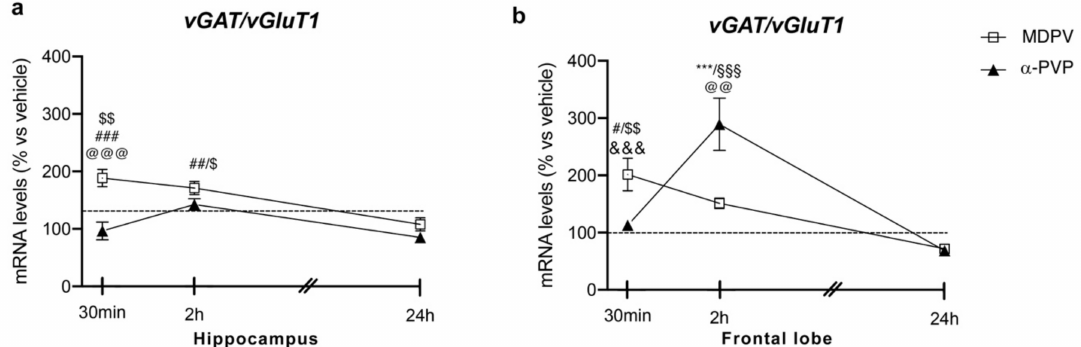
Figure 3. Time-dependent changes in vGAT/vGluT1 mRNA levels in the hippocampus ( a ) and frontal lobe ( b ) of mice following a single IP injection of MDPV (1 mg/kg) or α -PVP (1 mg/kg). Mice were sacrificed at three different time points, i.e., 30 min, 2 h, and 24 h after the drug administration. Results are expressed as percentages relative to vehicle-treated group and presented as mean ± standard error of the mean (SEM). *** p < 0.001 α -PVP versus vehicle- treated mice; # p < 0.05, ## p < 0.01, ### p < 0.001 MDPV versus vehicle- treated mice; $ p < 0.05, $$ p < 0.01 MDPV versus MDPV-24 h; @@ p < 0.01, @@@ p < 0.001 MDPV versus α -PVP; &&& p < 0.001 α -PVP versus α -PVP-2h; §§§ p < 0.001 α -PVP versus α -PVP-24 h (two- way ANOVA followed by Tukey’s multiple comparisons